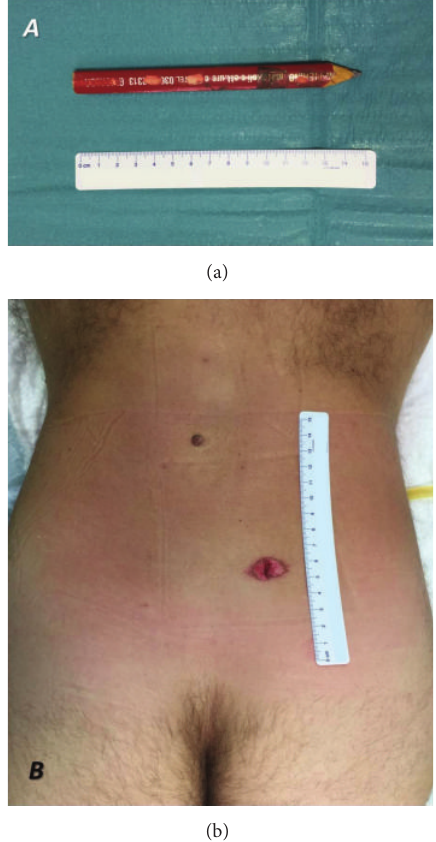
Figure 1: The wound caused by the penetrating object in the lumbosacralregion(b),slightlytotherightofthemidlineatthelevel of S1, and the penetrating object: a stonemason pencil